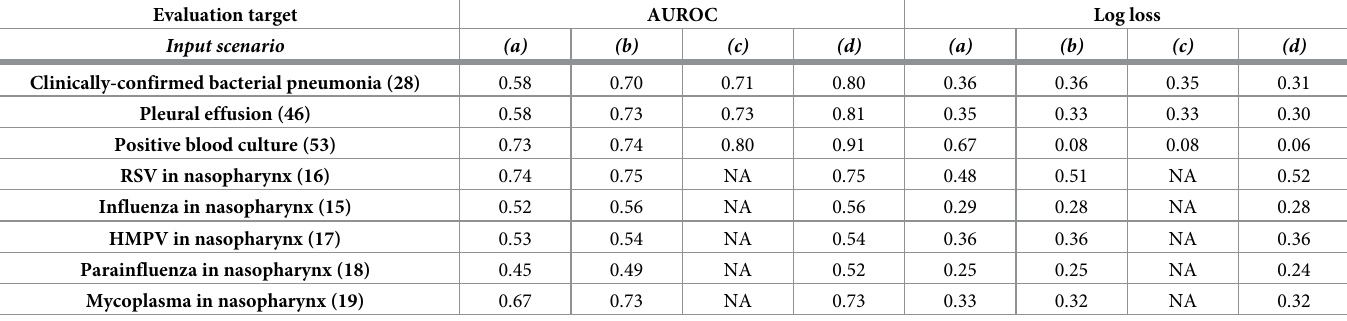
Table 1. The performance of BN v4.5 in predicting a range of evaluation targets under different input scenarios, in the form of mean log loss and AUROC based on 10-fold cross-validation. Note when the prediction targets themselves were included as observed variables in the corresponding input scenario, we removed them from the list of input variables. For example, no prediction about RSV in nasopharynx under input scenario (c) is made (and hence shown as NA) because RSV status is already known in that scenario. Raw results and scripts for generating these metrics can be accessed via Open Science Framework (https://osf.io/m97vb/).